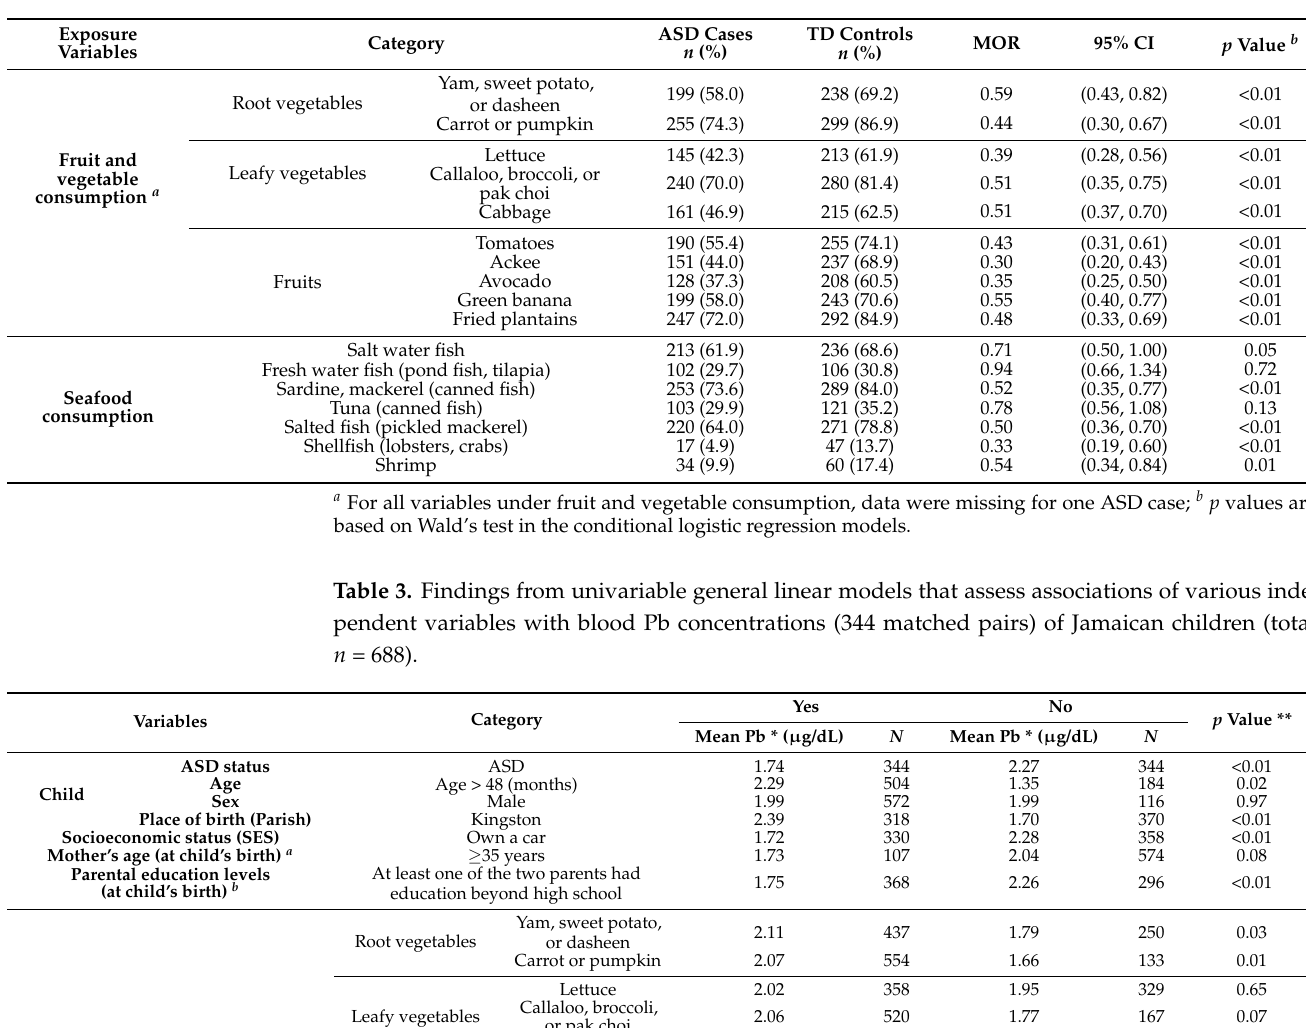
Table 2. Findings from conditional logistic regression (CLR) models related to associations between dietary or environmental factors and ASD case status (344 matched pairs).